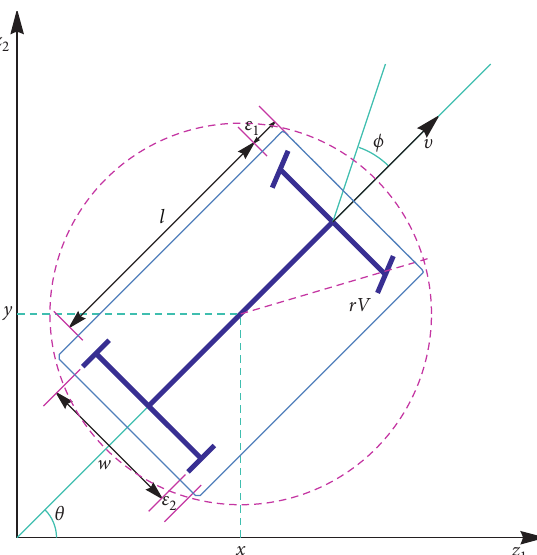
Figure 9: A rear wheel driven vehicle with front wheel steering and steering angle ϕ adopted from